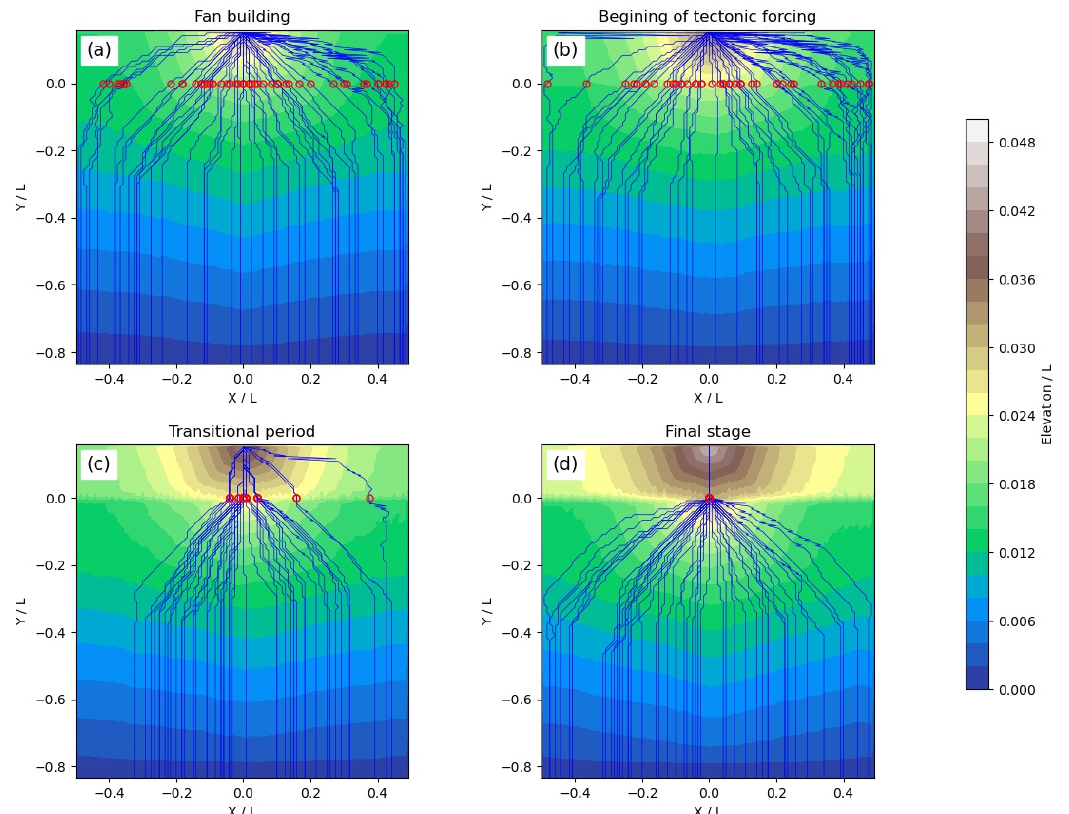
Figure 8. Landscape evolution of numerical modeling over a time duration of t end . The color scale shows the calculated elevation. Blue lines are associated with the channel drainage over a normalized time window of 1/27. Red circles give the location of the river outlet along the fault. ( a ) Time / t end = 0.17—Fan building period. ( b ) Time / t end = 0.42—Beginning of the tectonic forcing. ( c ) Time / t end = 0.63—The tectonic forcing causes the channel drainage localization on the hanging wall within a central valley. A new alluvial fan forms on the foot wall. ( d ) Time / t end = 0.88—Final phase of tectonic loading. The central valley deepens, and the channel remains localized along a single drain in the hanging wall.